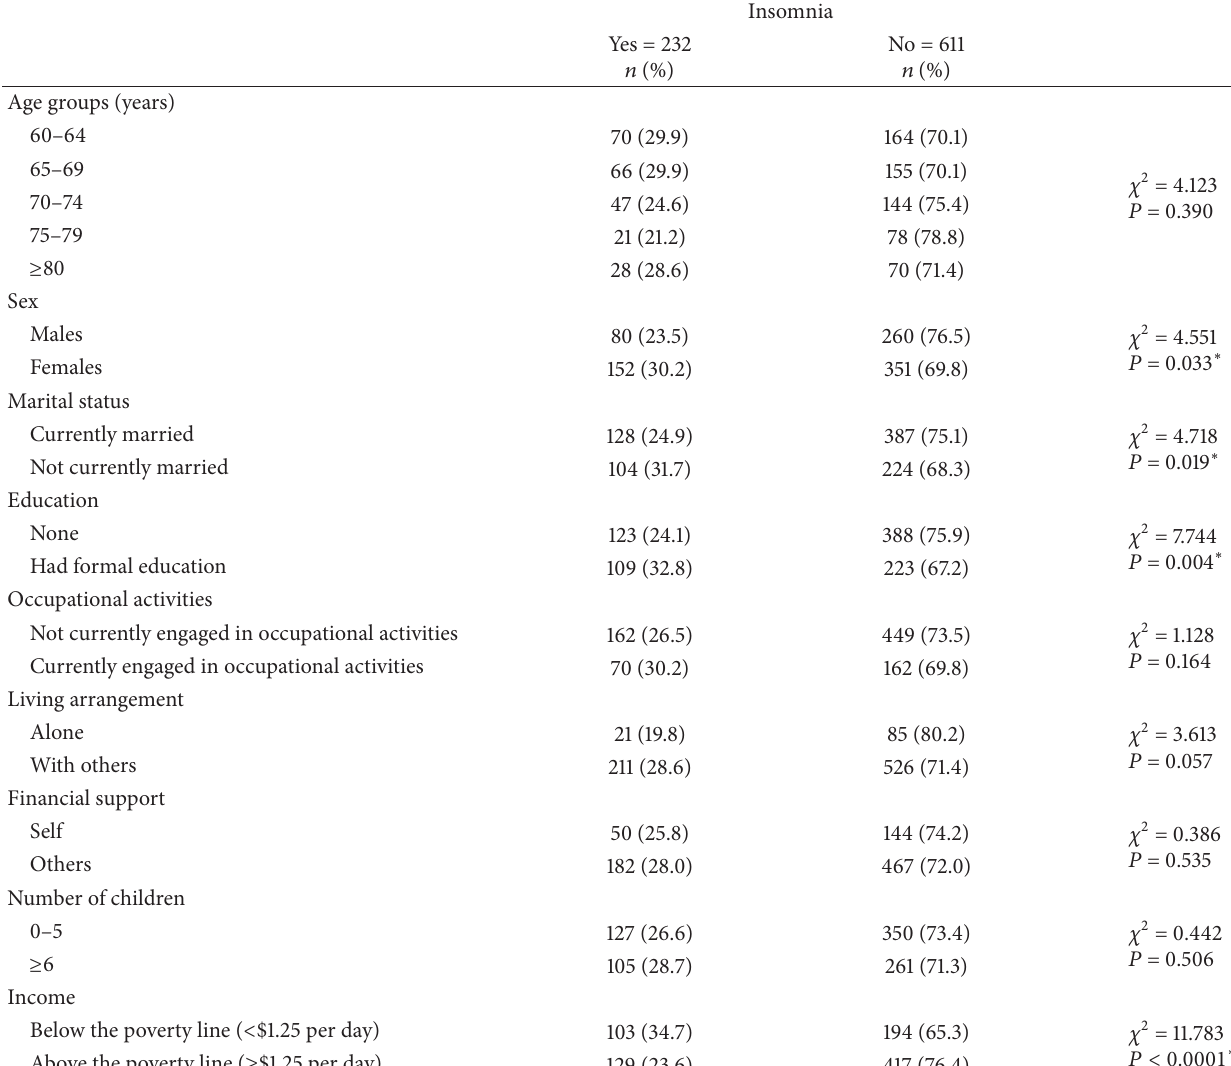
Table 2: Sociodemographic characteristics and the prevalence of